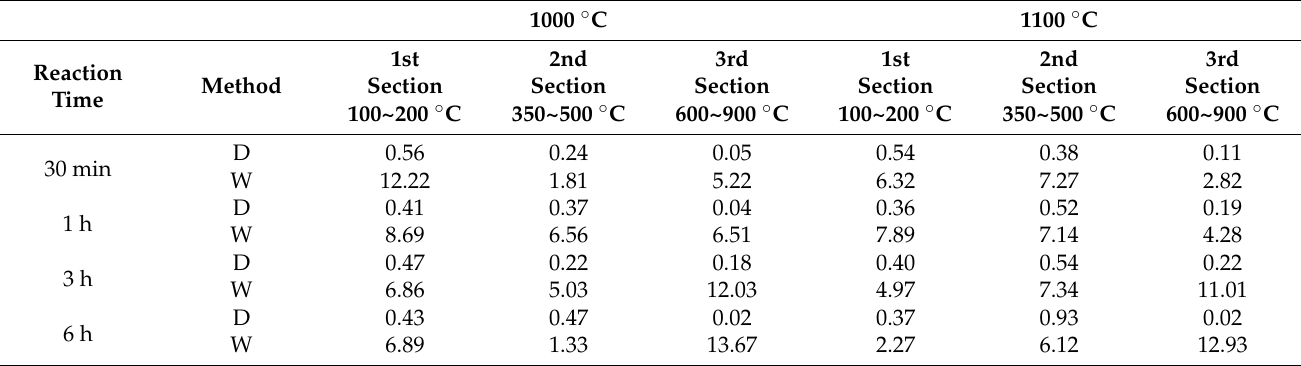
Table 1. The weight lost (wt.%) with reaction